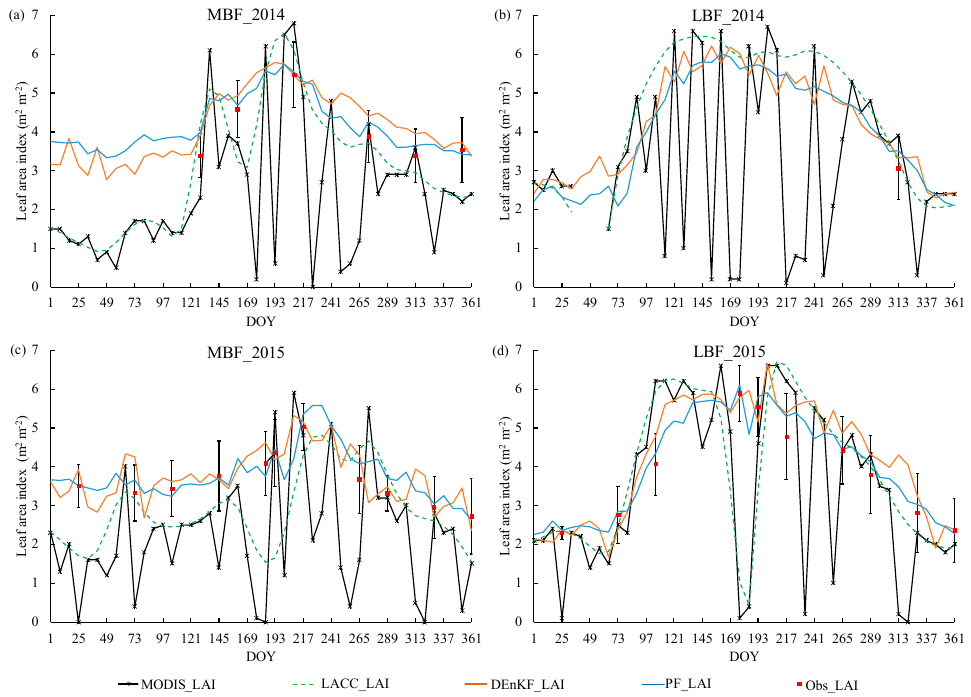
Figure 7. Time series of Obs_LAI, MODIS_LAI and LACC_LAI, DEnKF_LAI and PF_LAI of MBF in 2014 ( a ) and 2015 ( c ), and those of LBF in 2014 ( b ) and 2015 ( d ).